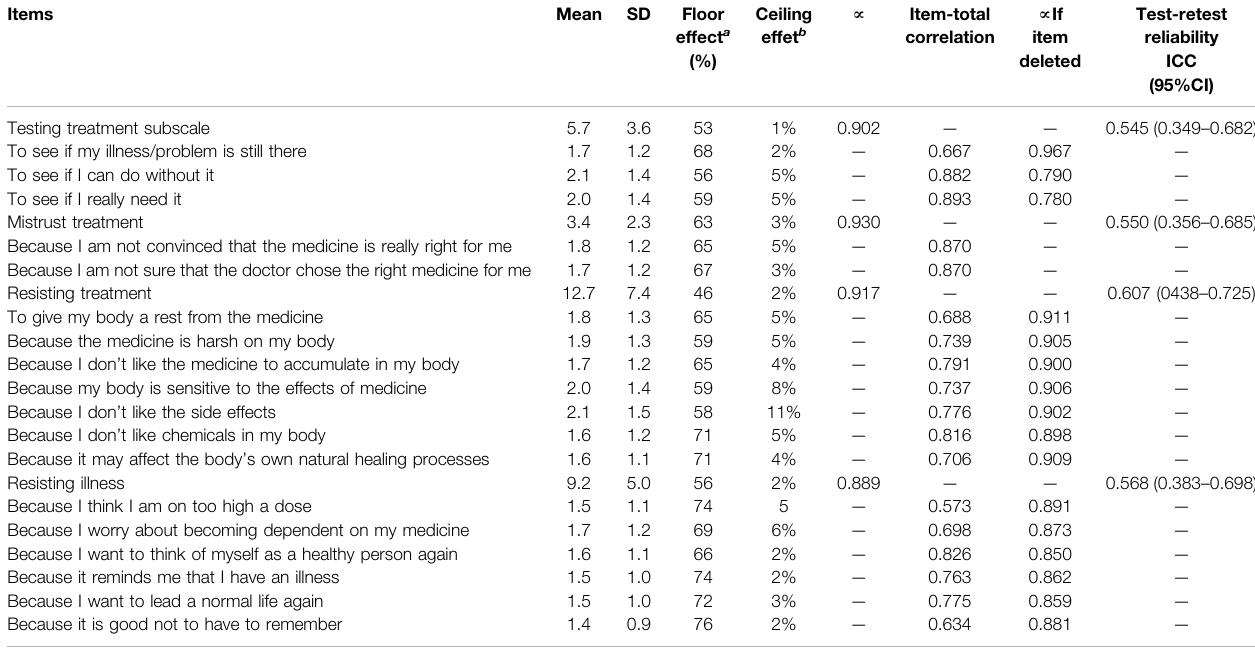
a Percentage of subjects scoring in the minimum of the scale ( fl oor effect). b Percentage of subjects scoring in the maximum of the scale (ceiling effect).